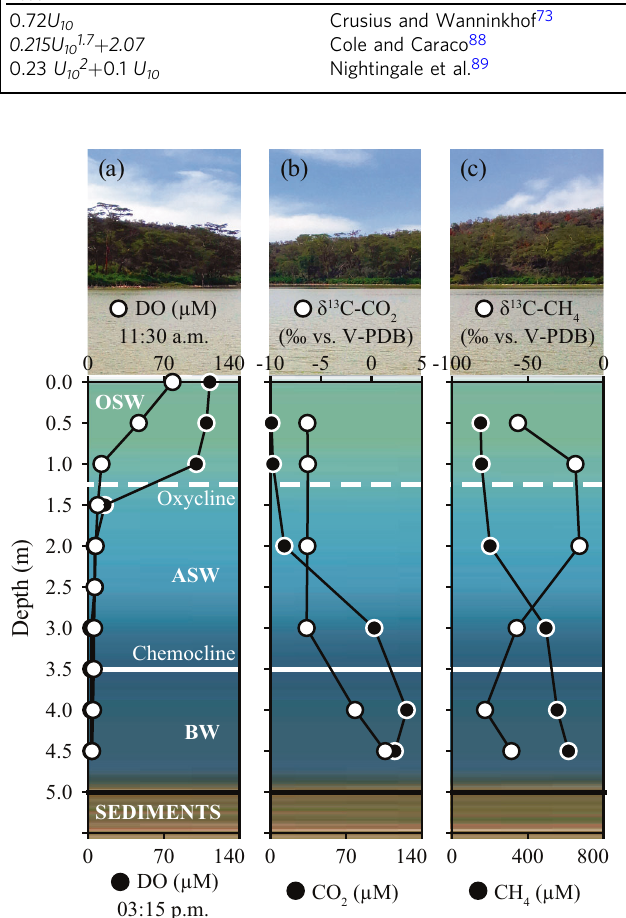
Fig. 2 Vertical pro fi les of dissolved gases and isotopic signatures across the water column. a Concentrations of dissolved oxygen (DO, at two daytime samplings). b CO 2 concentration (black dots) and δ 13 C-CO 2 ‰ vs. V-PDB (white dots). c CH 4 concentration (black dots) and δ 13 C-CH 4 ‰ vs. V-PDB (white dots).